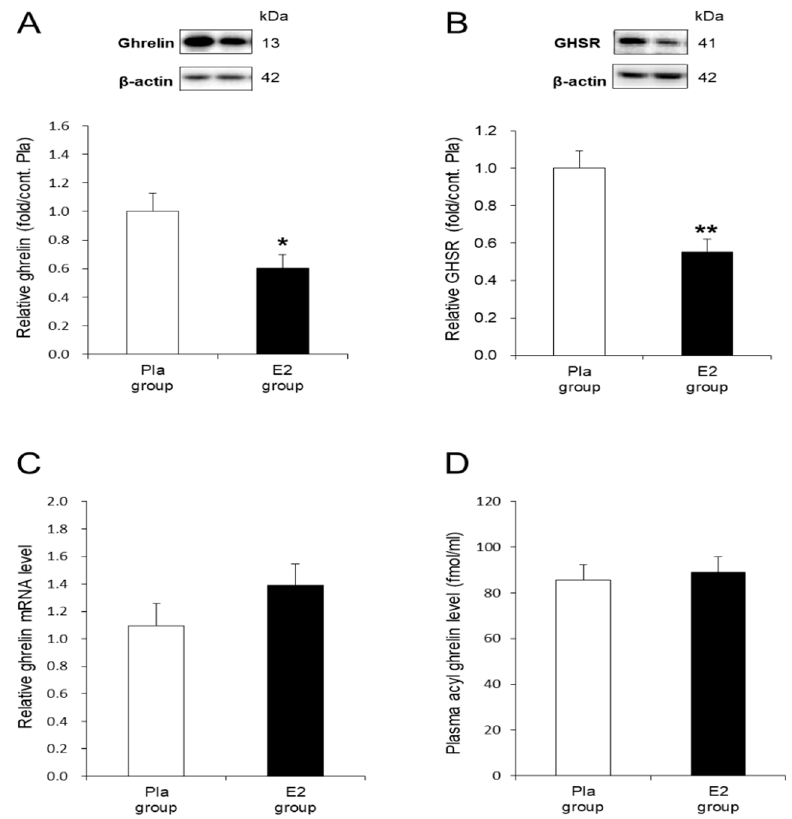
Figure 3. In vivo e ff ects of 17 β -estradiol (E2) replacement on ghrelin and growth hormone secretagogue receptor (GHSR) in the stomach. ( A ) Representative blots and relative values of ghrelin protein level in the gastric mucosa of HFD-fed rats in the placebo (Pla, n = 9)- and E2 ( n = 8)-treated groups. ( B ) Representative blots and relative values of GHSR protein level in the stomach of the rats in the Pla ( n = 11) and E2 ( n = 10) groups. ( C ) Relative values of ghrelin mRNA level in the gastric mucosa of the rats in the Pla ( n = 8) and the E2 ( n = 8) groups. Data are evaluated as 2 − ∆∆ Ct using β -actin as a housekeeping gene. ( D ) Plasma acyl ghrelin level after 16-h fasting in the Pla ( n = 9) and the E2 ( n = 8) groups at 17 weeks of age. Data are expressed as means ± SE and were analyzed by unpaired t -test. * p < 0.05 and ** p < 0.01, di ff erences between E2 and Pla groups.